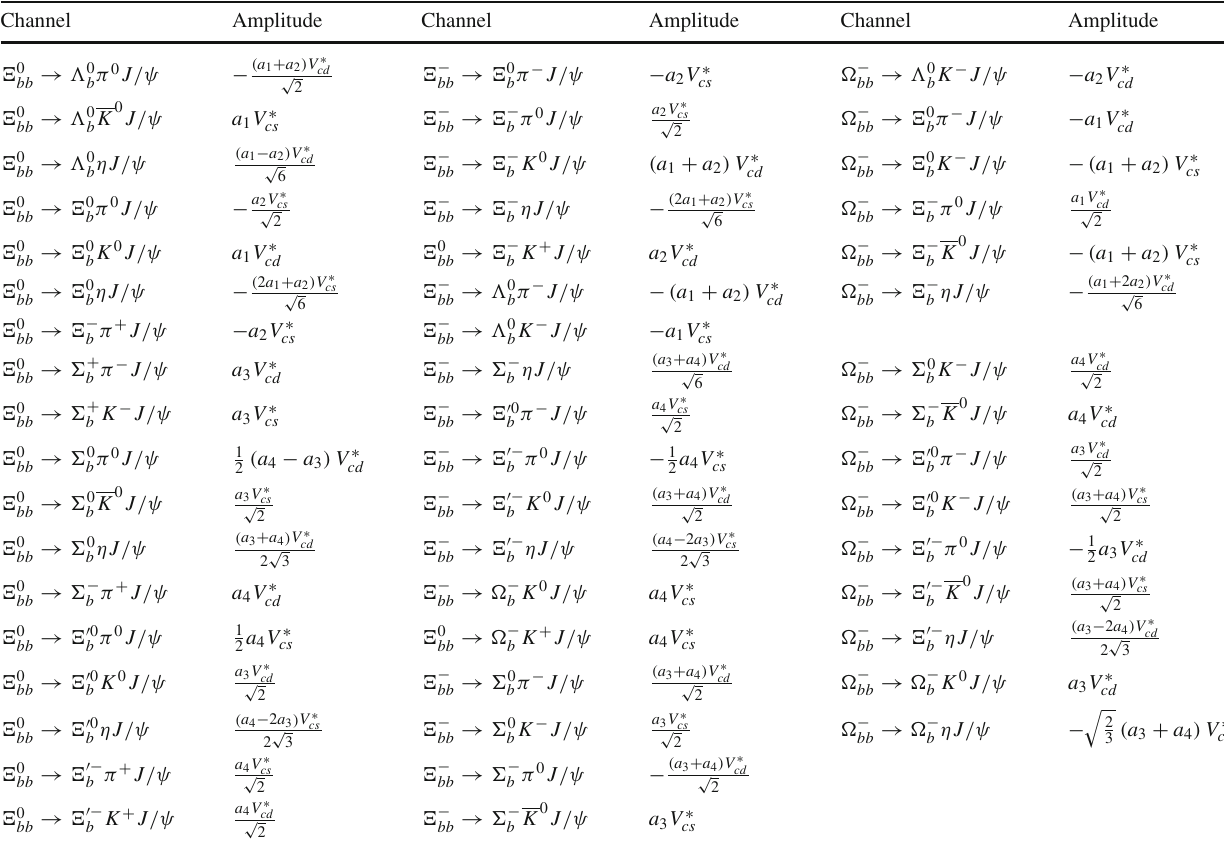
Table 15 Doubly bottom baryon decays into a J /ψ , light baryon and a light meson Channel Amplitude Channel Amplitude Channel